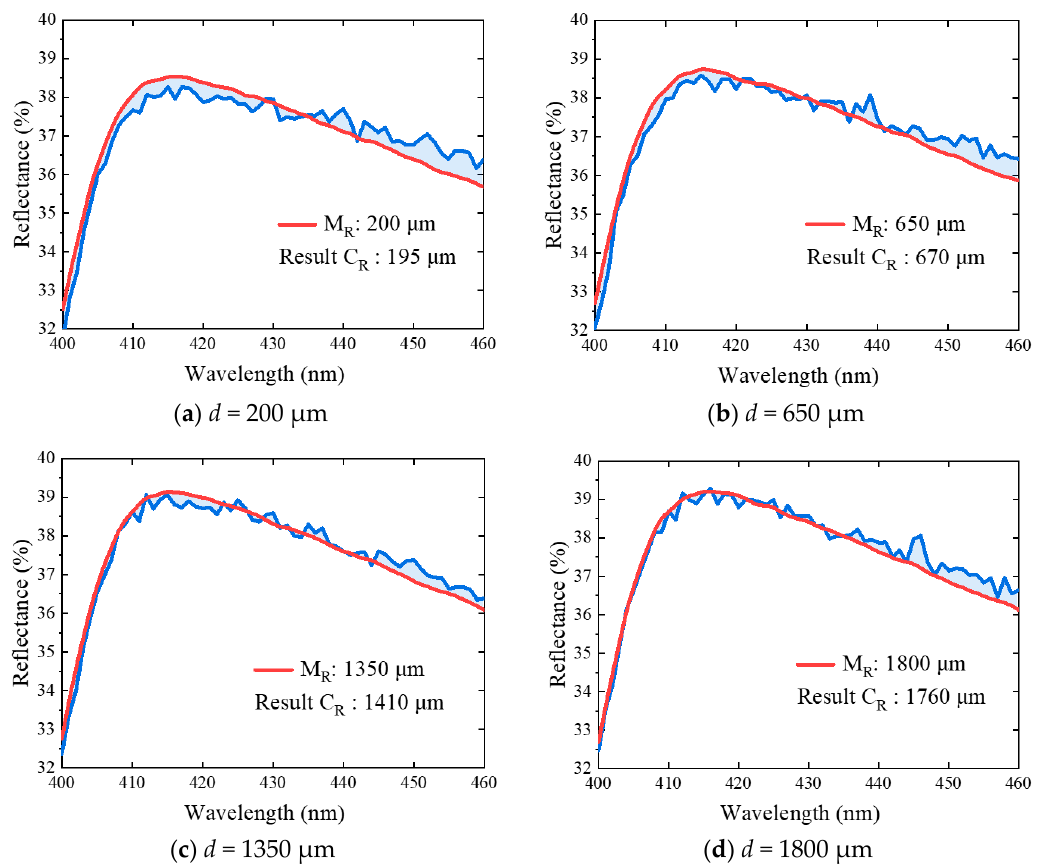
Figure 17. Comparison between the measured and calculated spectroscopic data in the discrete vessel skin phantom with Figure 17. Verification of blood vessel depth extraction (400–460 different depths.